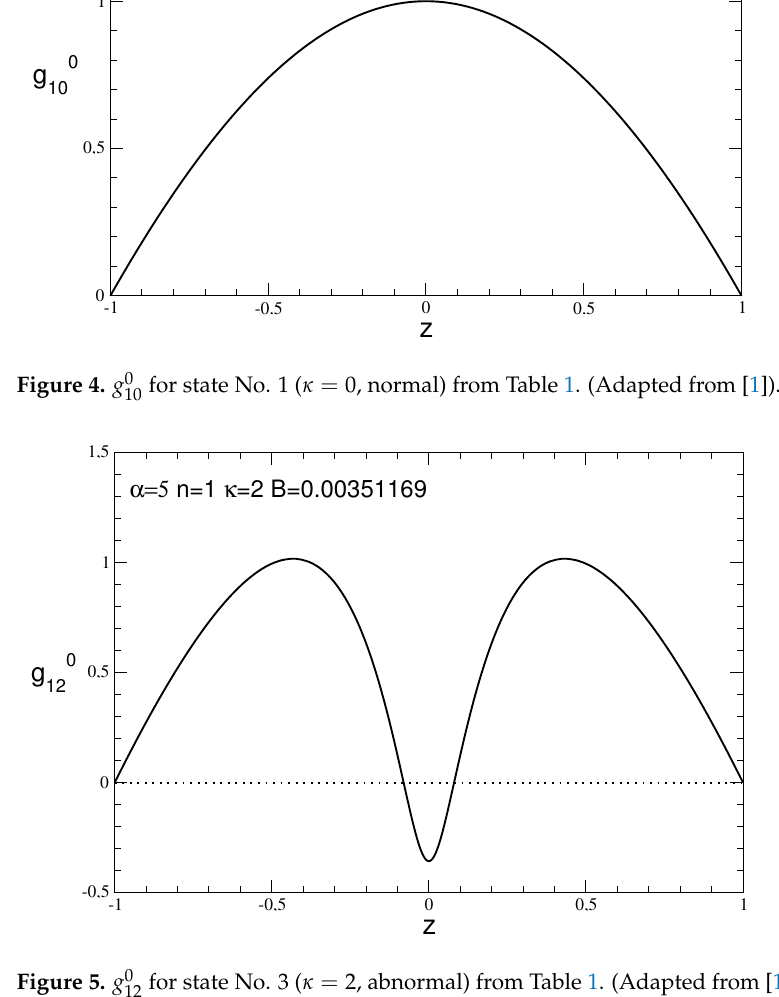
Figure 5. g 0 for state No. 3 ( κ = 2, abnormal) from Table 1. (Adapted from 12